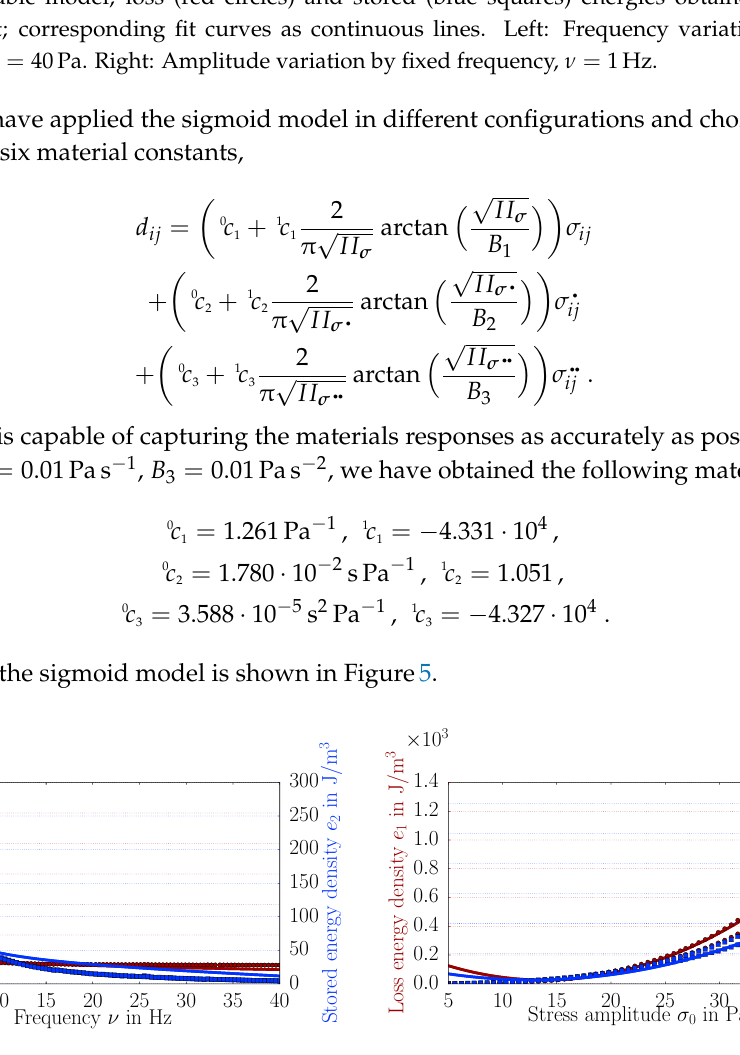
Figure 5. Sigmoid model, loss (red circles) and stored (blue squares) energies obtained from the measurement; corresponding fit curves as continuous lines. Left: Frequency variation by fixed amplitude, σ 0 = 40Pa. Right: Amplitude variation by fixed frequency, ν =